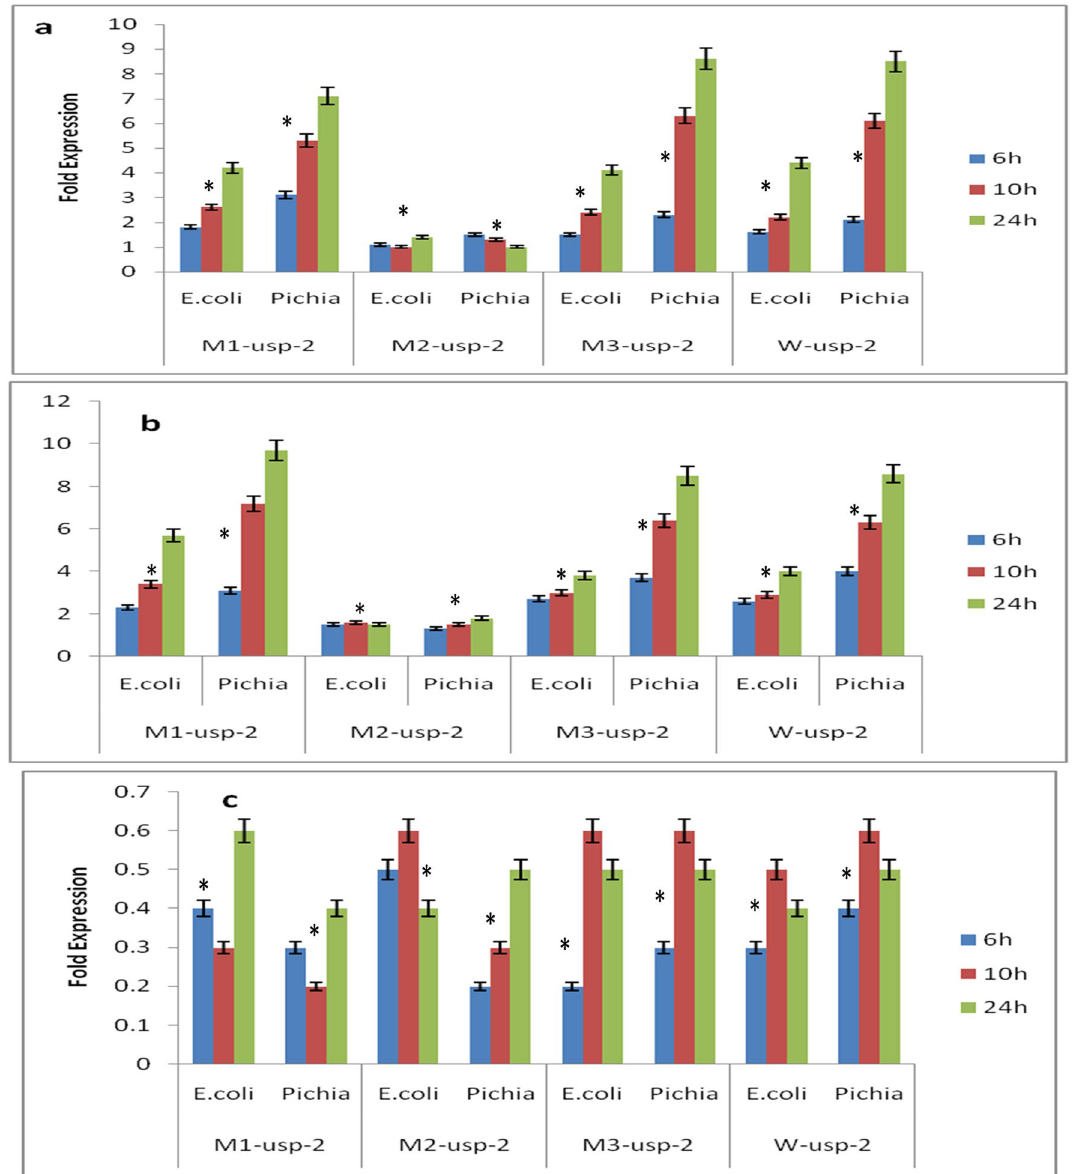
Figure 7. Relative expression level of mutant and wild type genes ( M1-usp-2 , M2-usp-2, M3-usp-2 & W-usp-2 ) in E. coli and, data was analyzed by comparative CT method and presented as relative fold gene expression (2 − ΔΔC T) with reference rssA gene. The graph indicates the mean ± SD ( a ) relative expression under NaCl 800 mM stress. Expression of M1-usp-2 was significant in in BL-21-uspABC cells (4.2 fold). While M2-usp-2 W-usp-2, M3-usp-2 genes have slight expression (4.4 & 4.1fold), ( b ) relative expression under PEG 8% stress. M1-usp-2 relative expression was significant in E. coli BL-21-uspABC cells (5.7 fold). Again M2-usp-2 gene expression was not notably different (4 & 3.8 fold) ( c ) relative expression under heat stress in E. coli BL-21-uspABC cells had not been observed at notable difference either because the death of cells at high temperature or because the wild type and mutant genes conferred no resistance against heat